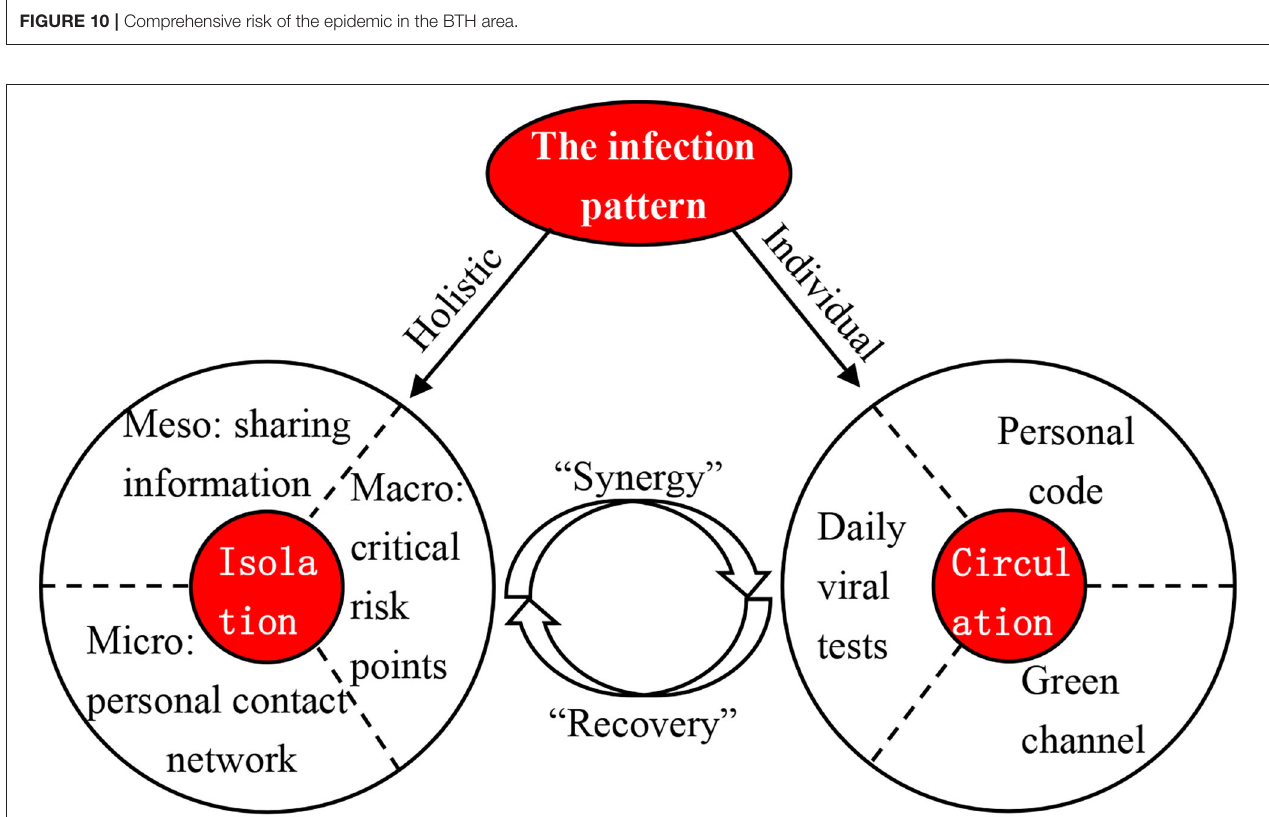
FIGURE 11 | Conceptual framework of the “two-wheels”